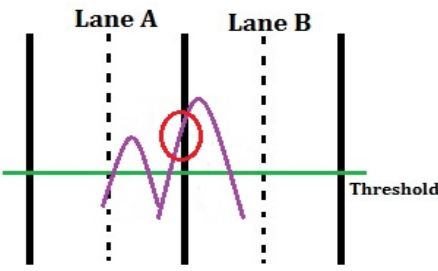
Figure 10. An example of the FFT main lobe lying within the right lane and a FFT side lobe lying within the left lane.